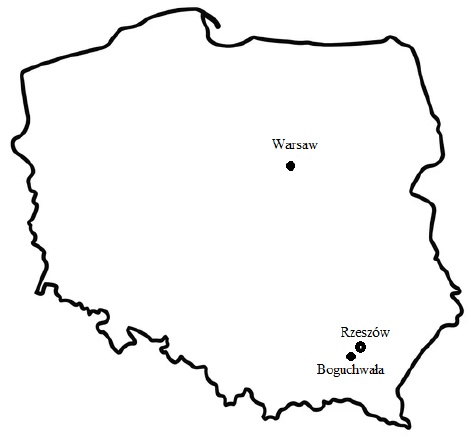
Figure 1. Locations of legume experiments.